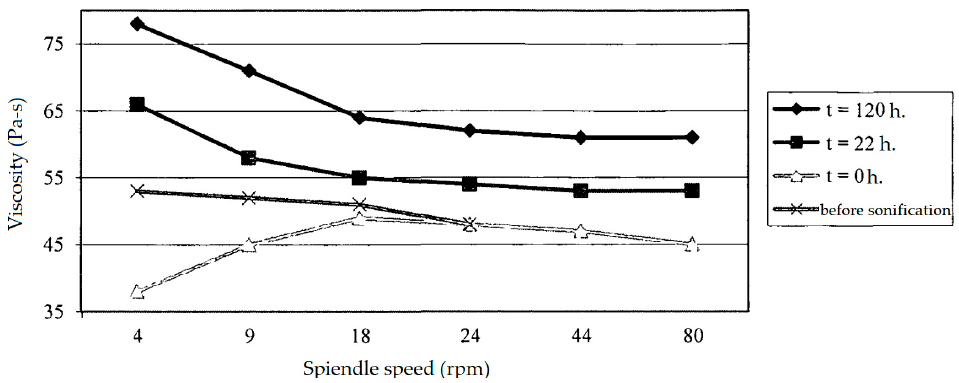
Figure 4. Viscosity of highly para ffi nic oil before and after ultrasonic